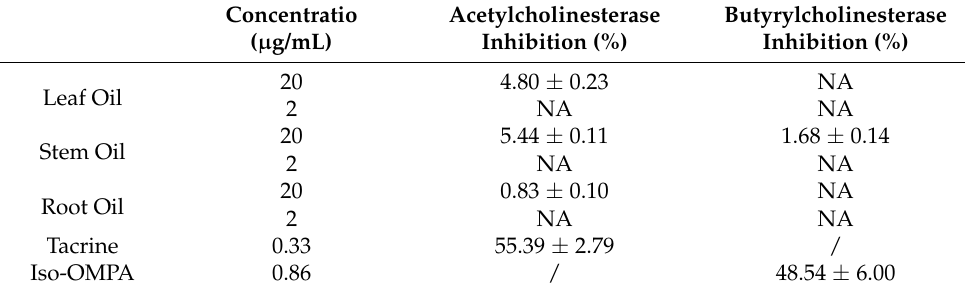
Table 4. Cholinesterase inhibition activity of K. coccinea essential